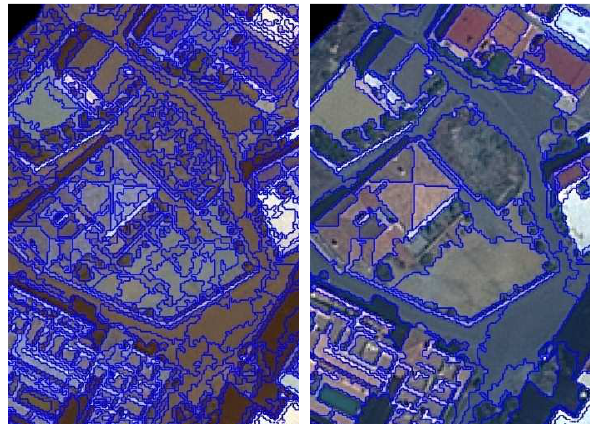
Figure 3. Multiresolution segmentation. Left: Scale 20 at pixel level. Right: Scale 70